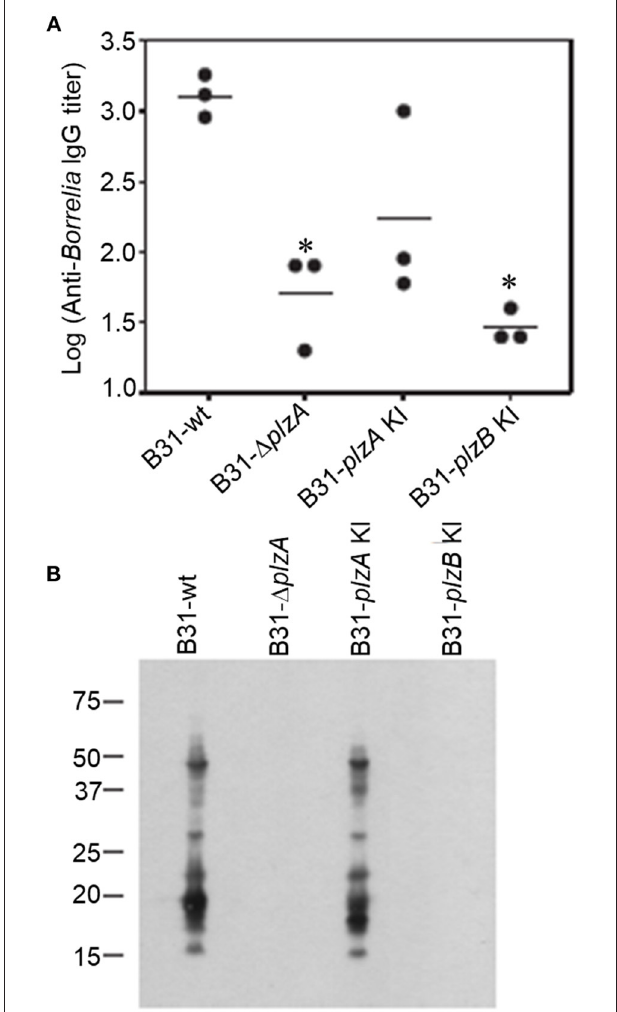
FIGURE 5 | Tick to mouse spirochete transmission analyses. I. scapularis larvae were infected with each strain by immersion in actively growing cultures. After verifying infection, the infected larvae were fed on naive C3H-HeJ mice. Serum was collected from each mouse 4 weeks post-inoculation and anti -B. burgdorferi IgG titer was determined by ELISA (endpoint dilution) using whole cell lysate as the detecting antigen (A) . (B) Shows the results of immunoblot analyses. B. burgdorferi B31 served as the immobilized antigen. For the immunoblot analyses, serum samples from each experimental group were pooled. All methods were conducted as detailed in the text and statistical significance was assessed using the One-Way ANOVA. *Statistical significance was assessed relative to wild type ( p <